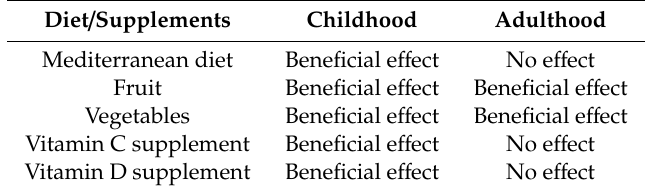
a Table derived from Reference